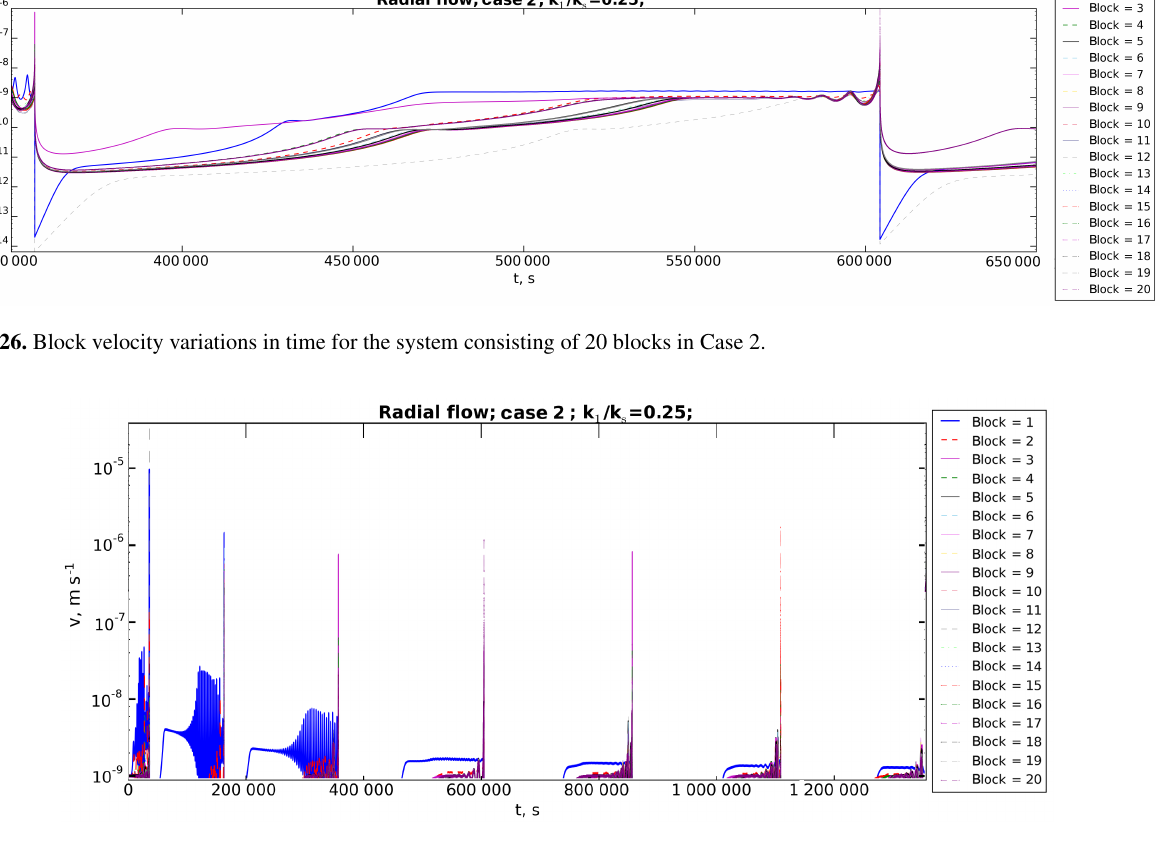
Figure 27. Seismic event occurrences in time for the system consisting of 20 blocks in Case